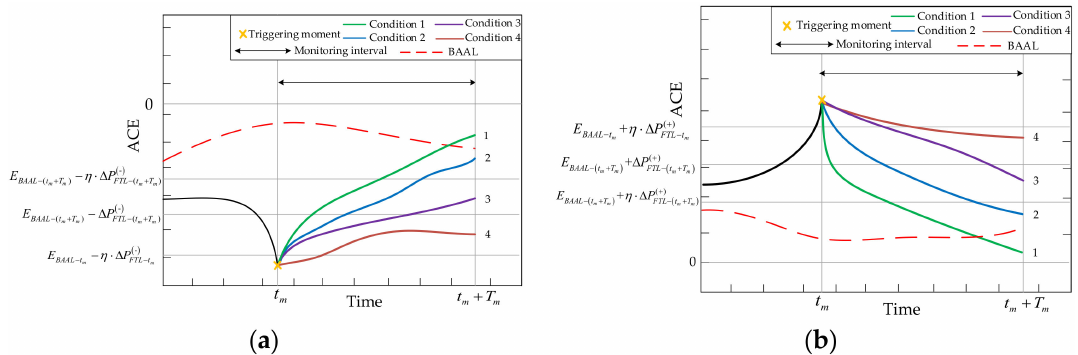
Figure 2. Different ACE fluctuations after the triggering moment: ( a ) negative frequency deviation; ( b ) positive frequency